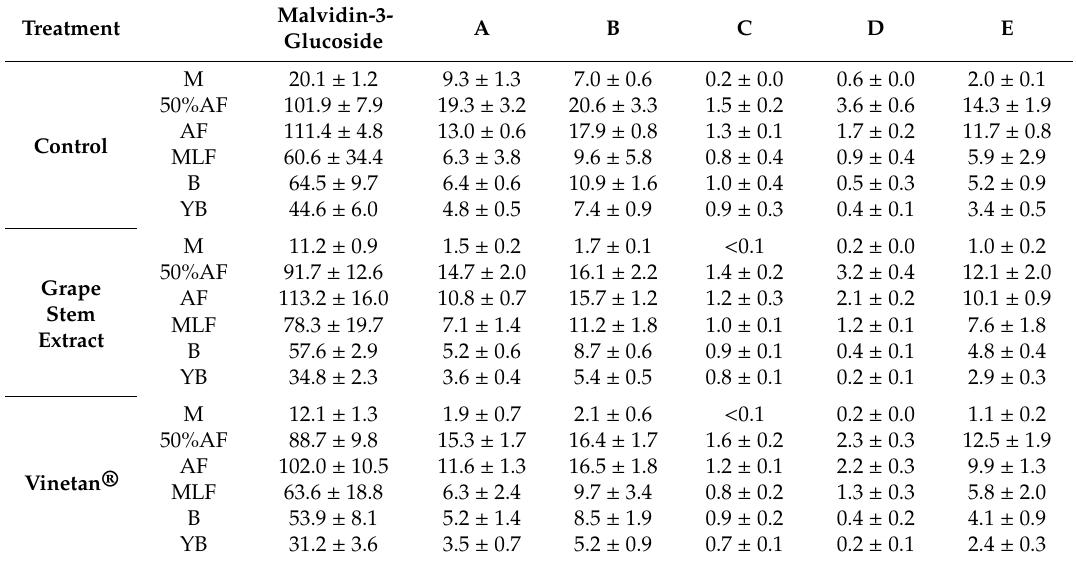
Table 4. Anthocyanin concentration ( µ g / mL) in control samples and samples with addition of grape stem extract or commercial extract (Vinetan ® ) during winemaking (M = must; 50% AF = 50% alcoholic fermentation; AF = end of alcoholic fermentation; MLF = end of malolactic fermentation; B = bottling; YB = one year after bottling) (Mean ± SD, n = 6). Results were obtained